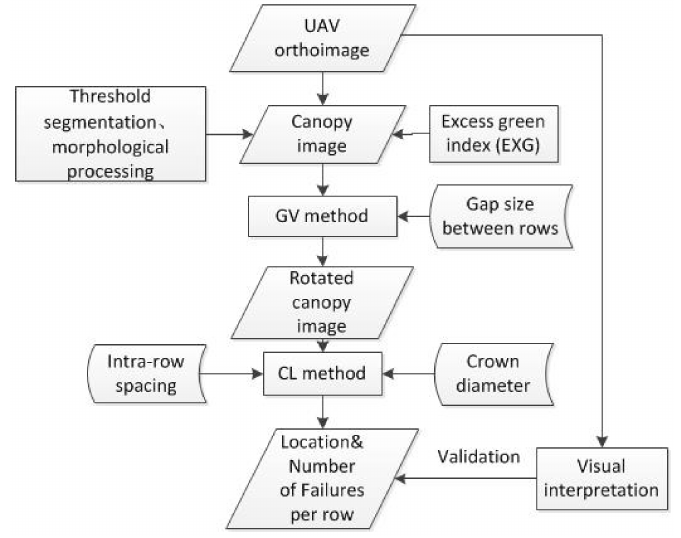
Figure 2. Outline of the methodology.